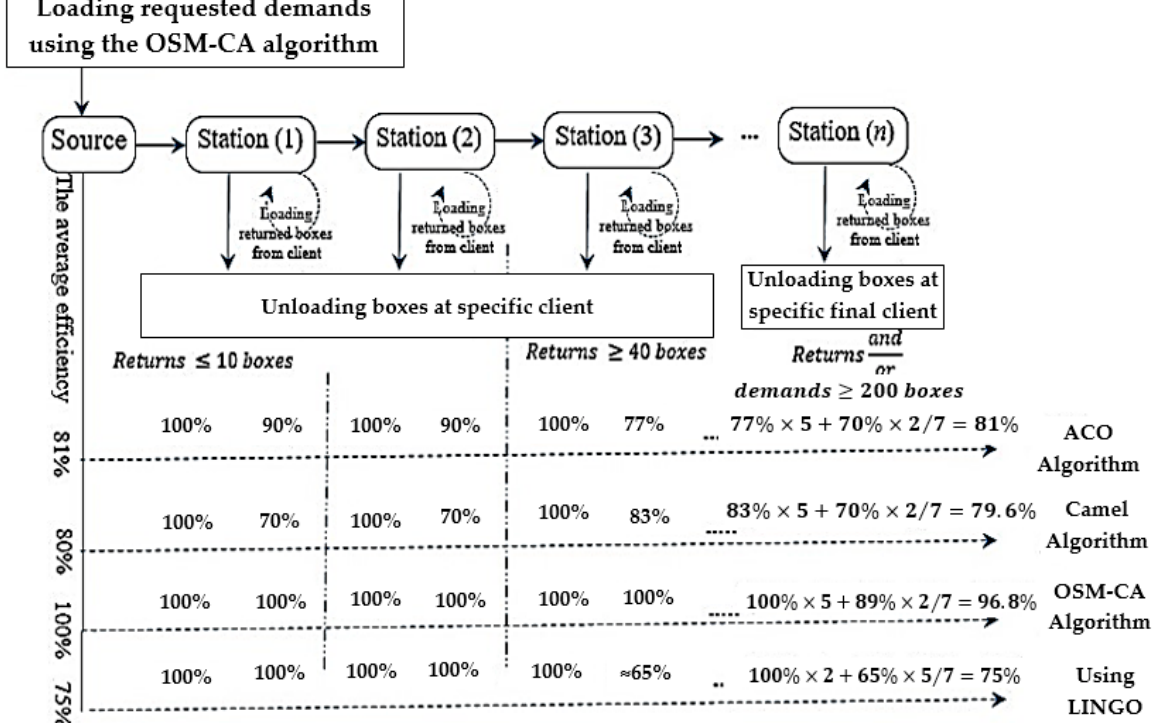
Figure A2. The efficiency of transportation system on distribution path aggregated via IoT for seven stations (n = 7).